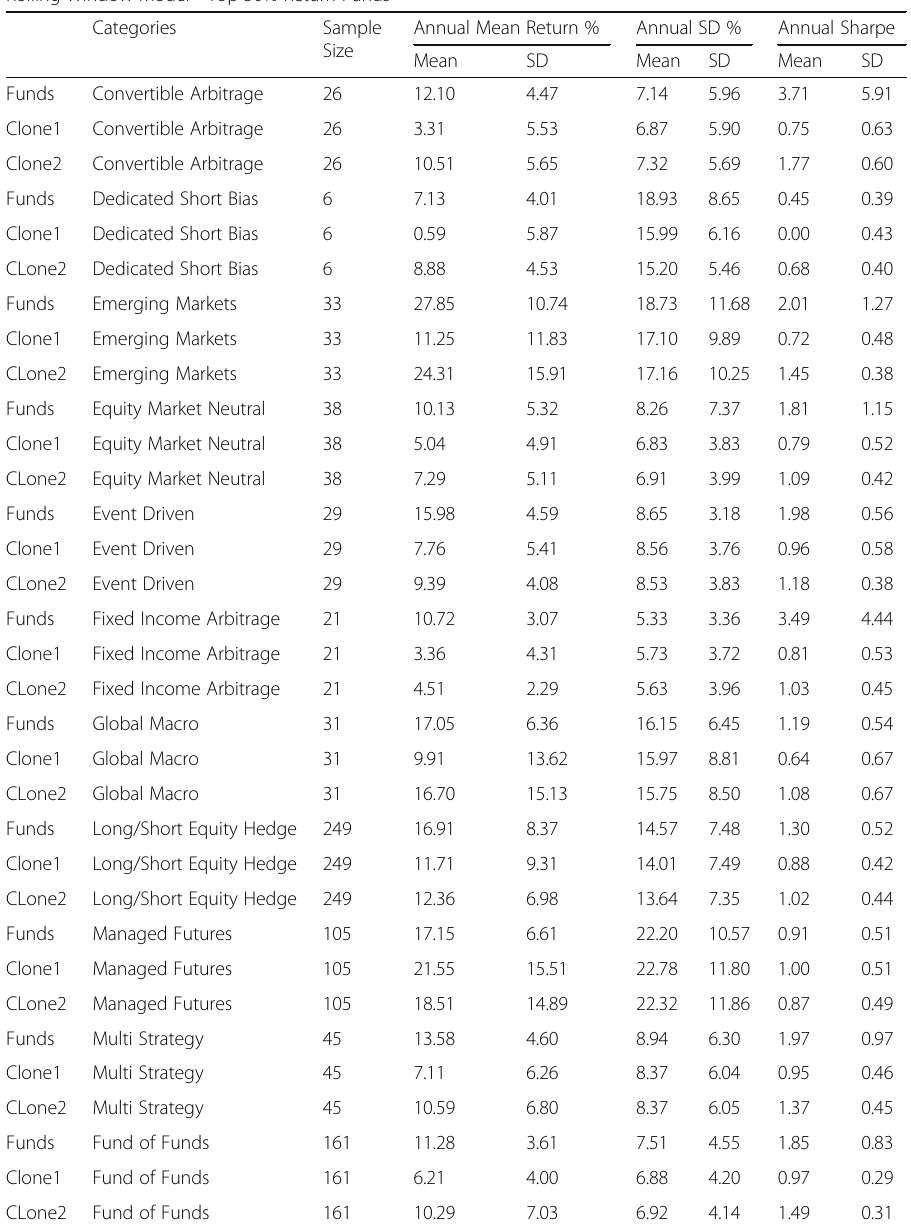
Table 6 Performance comparison for rolling window model for top 50% return funds and their